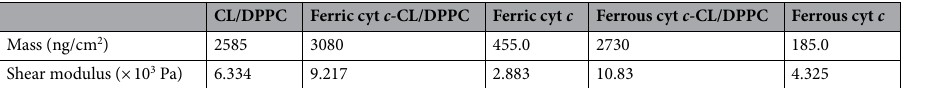
Table 1. Mass and shear modulus of the CL/DPPC supported lipid membranes, cyt c -bound CL/DPPC complex, and cyt c (difference between the former two). The values were estimated based on the Kelvin–Voigt